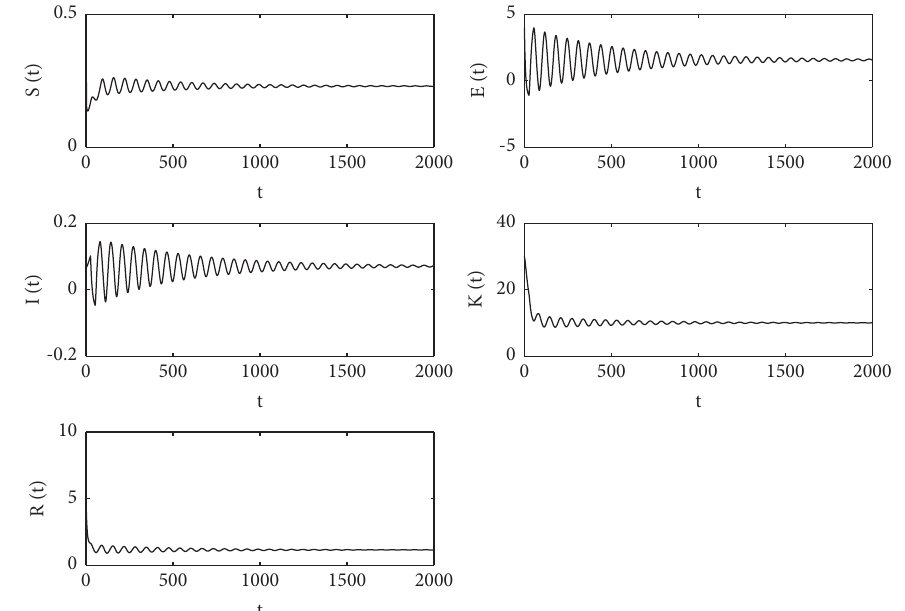
Figure 3: State trajectories of fractional system (4). When τ ymptotically stable.